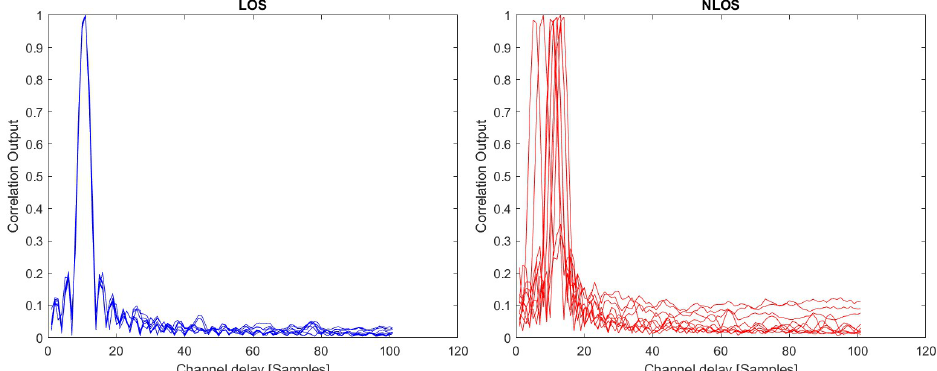
Figure 8. Examples of correlation outputs for SRS signals with measurement data; ( left ): LOS scenarios; ( right ): NLOS scenarios.